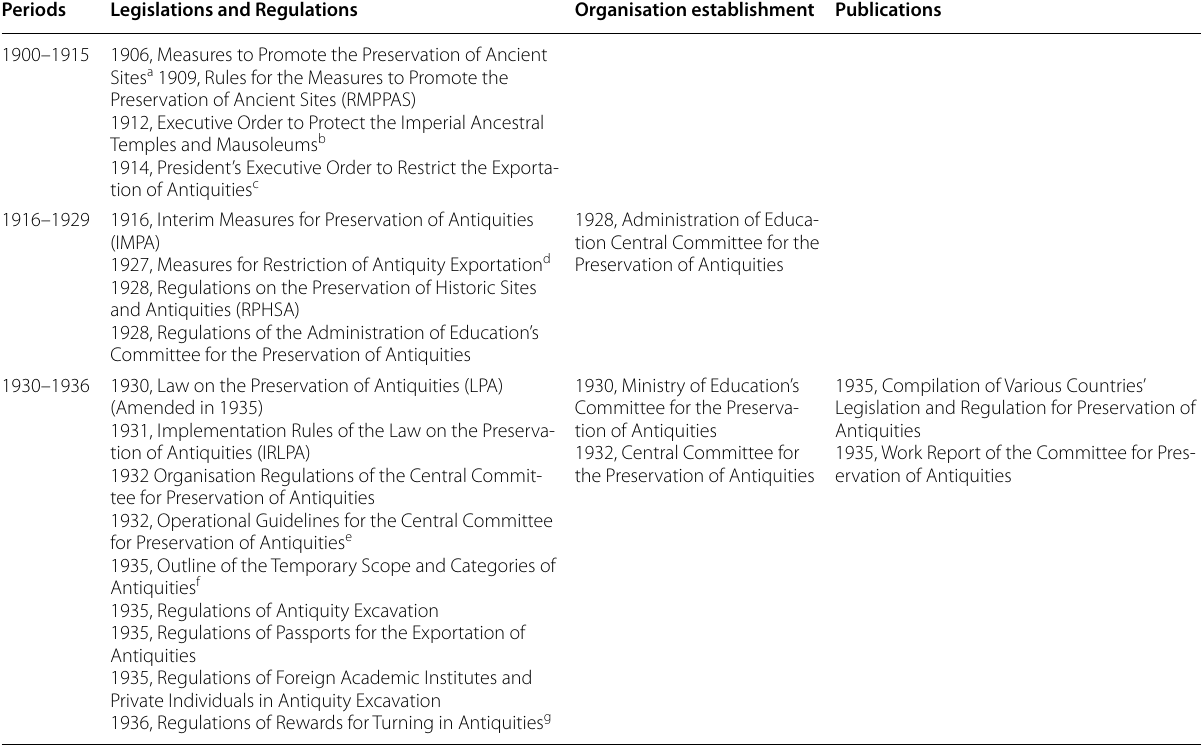
Table 2 List of events related to the legislation of antiquity preservation during the late Qing Dynasty and ROC